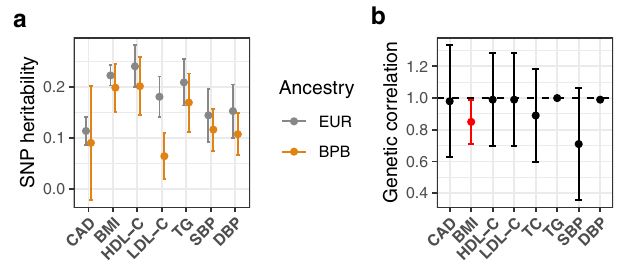
Fig. 2 | SNP heritability and trans-ancestry genetic correlations for cardiome- tabolic traits. a SNP heritability was estimated using GCTA in G&H (orange) and eMERGE (grey) for cardiometabolic traits, namely coronary artery disease (CAD; n =17,348 and 32,816 unrelated samples from G&H and eMERGE, respectively), body-massindex(BMI; n =13,926and37,160),high-densitylipoproteincholesterol (HDL-C; n =11,316 and 16,049), low-density lipoprotein cholesterol (LDL-C; n =12,856 and 15,856), triglycerides (TG; n =11,125 and 14,384), systolic blood pressure (SBP), and diastolic blood pressure (DBP; n =15,908 and 11,864 for blood pressure). Medication data are not available in eMERGE so the highest measure- ments for LDL-C, SBP, and DBP are used. Error bars represent 95% con fi dence intervals in bothplots. b Geneticcorrelationswereestimated using Popcornbased on GWAS summary statistics generated from G&H and European-ancestry indivi- duals from UK Biobank. Red indicates that the genetic correlation is nominally signi fi cantly lower than 1 ( p -value=0.02 for BMI; two-sided and not adjusted for multiple comparisons). Medication-adjusted lipid and blood pressure levels are used. For r g estimates of 1 (TG and DBP), the method cannot derive con fi dence intervals. Sample sizes of GWAS for cardiometabolic traits in G&H are in Table 1.